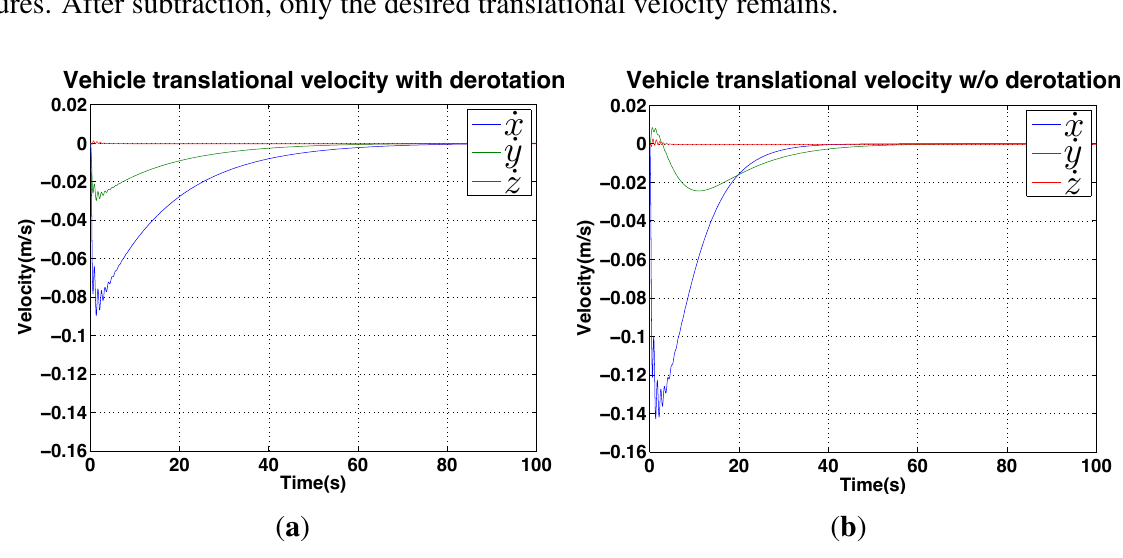
Figure 13. Simulation results for IBVS regulation: velocity response. ( a ) with de-rotation; ( b )